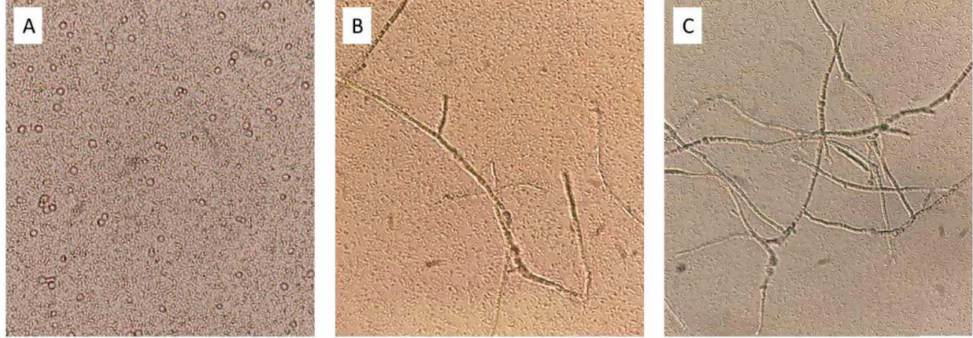
Figure 1. Light microscopy pictures ( × 40) of T. amestolkiae – L. plantarum M9MG6-B2 co-cultures after 72 h incubation. ( A ) Static conditions; ( B ) 20 rpm; ( C ) 200